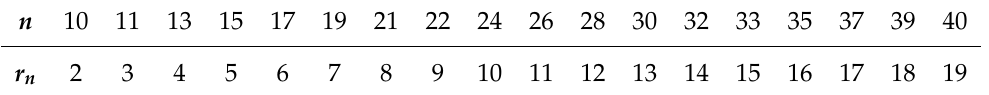
Table 2. Stopping boundaries of the modified version of the design by Zhou et al. [7], when N = 40, N min = 10, δ = 0.1, π ( p S ) = beta ( p S ;63,94 ) , π ( p E ) = beta ( p E ;1.4,1.6 ) and the nominal level for the type I error rate is